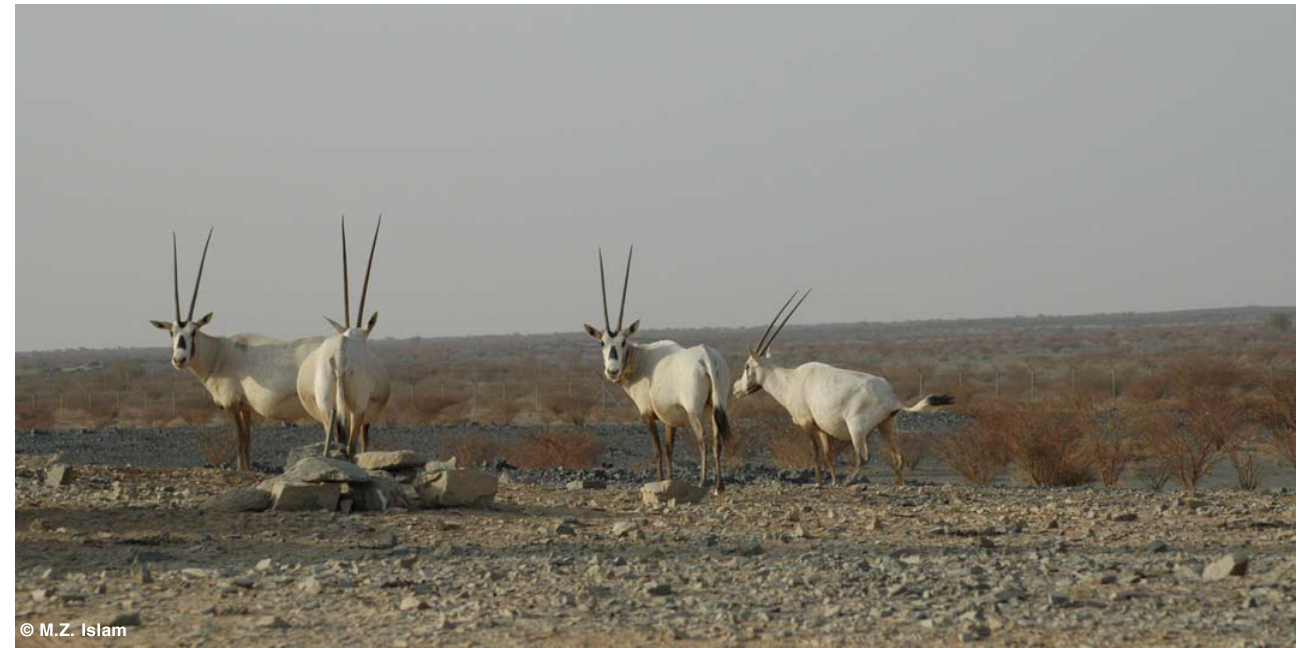
Image 5. Arabian Oryx near the camp waiting for water. Dry acacia plants can be seen in the